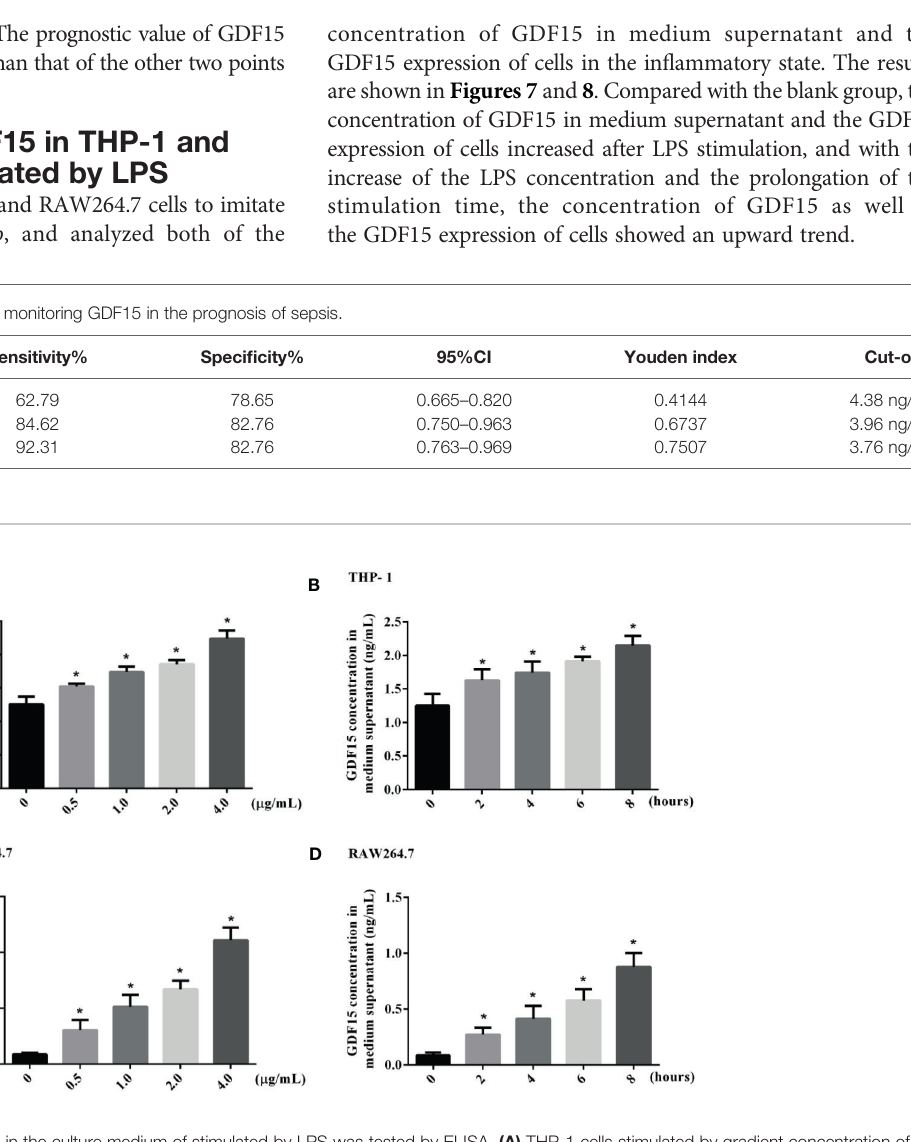
FIGURE 7 | The concentration of GDF15 in the culture medium of stimulated by LPS was tested by ELISA. (A) THP-1 cells stimulated by gradient concentration of LPS; (B) THP-1 cells stimulated by gradient time of LPS; (C) RAW264.7 cells stimulated by gradient concentration of LPS; (D) RAW264.7 cells stimulated by gradient time of LPS. * P < 0.05, compare with the blank